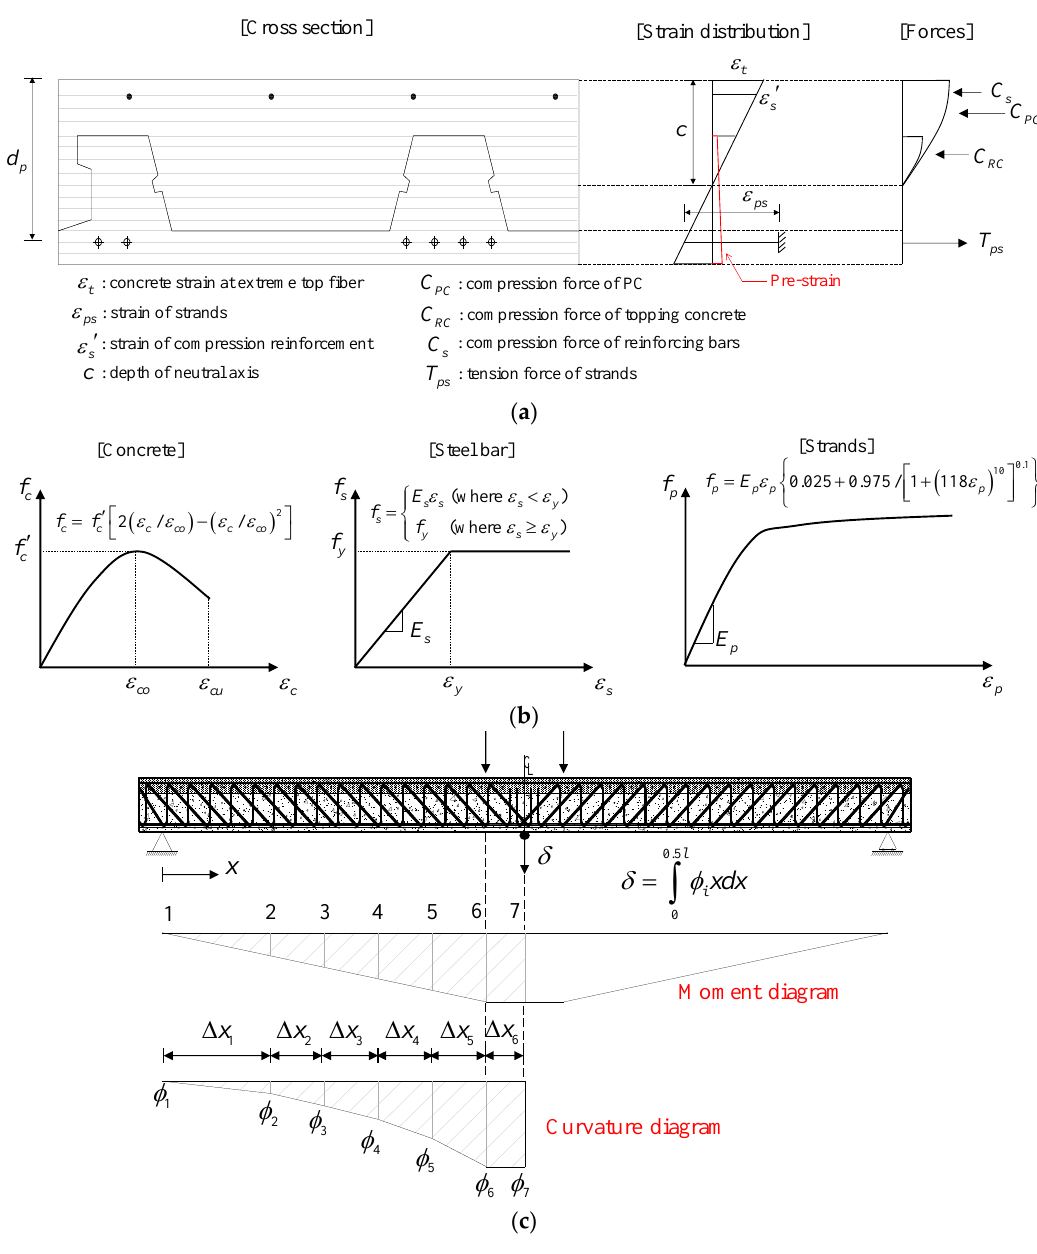
Figure 8. Non-linear flexural analysis; ( a ) Layered analysis model; ( b ) Constitutive laws of materials; ( c ) Numerical integration for estimating mid-span deflection.